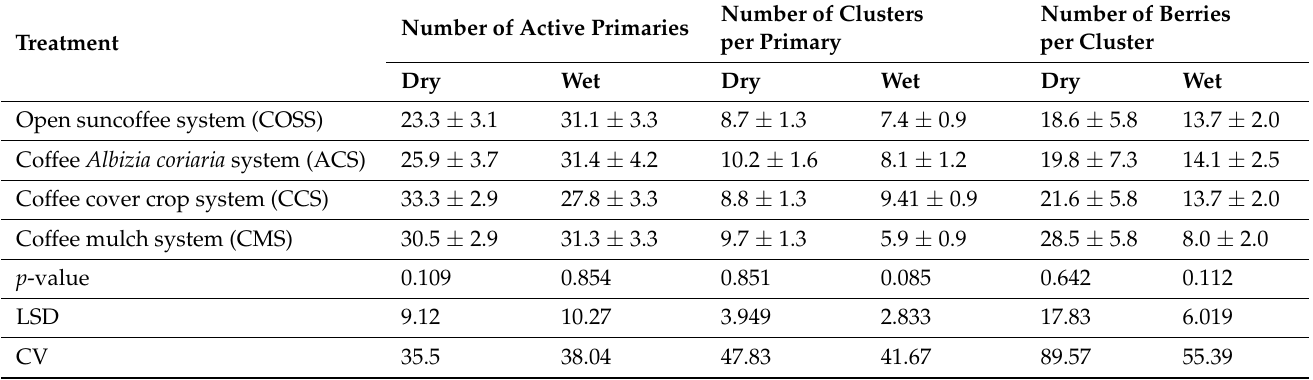
Table 8. Effects of selected SMCPs on coffee growth